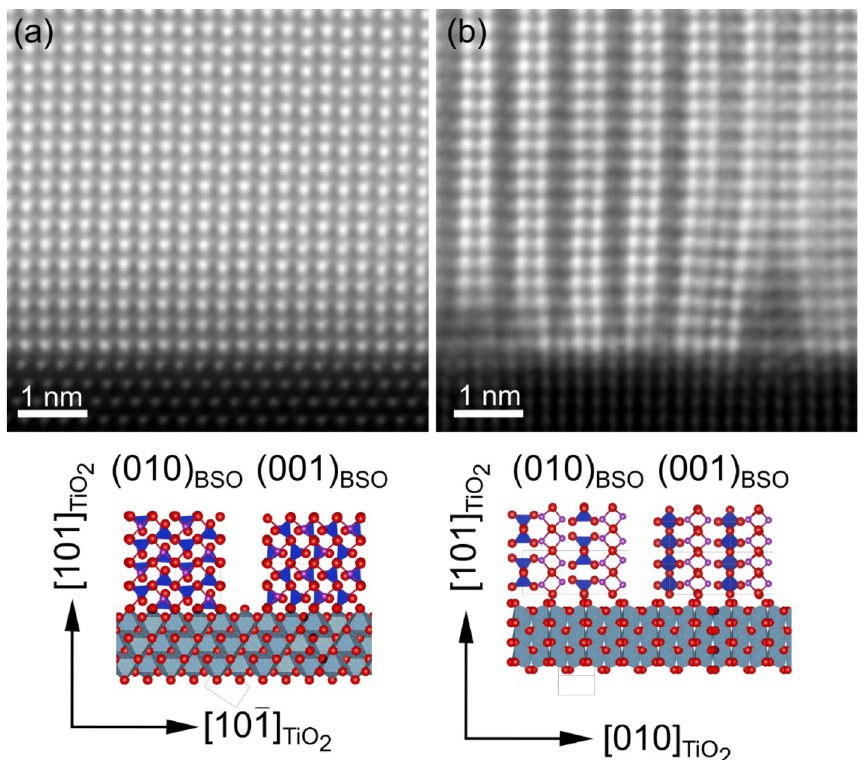
Figure 4. HAADF-STEM images for BSO/(101)Nb:TiO 2 with a 300 nm thick film, viewed from ( a ) the [010] TiO2 , and ( b ) the [10–1] TiO2 directions.